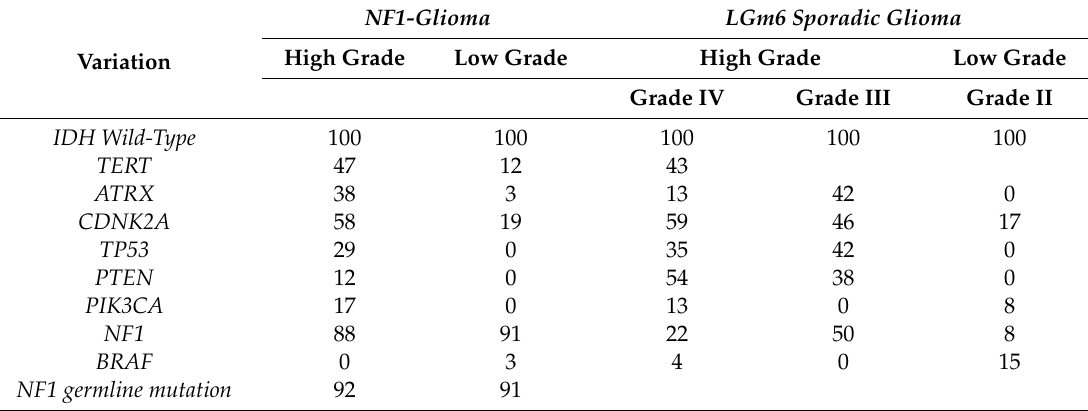
Figure 2. Optic pathway glioma and a high-grade cerebellar glioma in a young adult with NF1. ( A ) MRI brain, axial T2 sequence showing hyperintense left optic nerve lesion (arrow) and ill-defined hyperintense lesion within the left cerebellum (asterisk) associated with mass e ff ect. ( B ) Post-contrast T1 sequence showing heterogeneous enhancement of the left cerebellar lesion concerning high grade neoplasm (asterisk). Histopathologic evaluation of the left cerebellar lesion was consistent with glioblastoma, WHO grade IV, IDH wild-type ( C ) Infiltrating glioma exhibiting atypical cells and vascular endothelial proliferation (H&E, 200 × ). ( D ) Tumor cells are negative for IDH1 (R132H) mutant protein (IHC, 200 × ). Table 1. Somatic and Germline alterations in NF1-Glioma compared to the LGm6 subgroup of sporadic